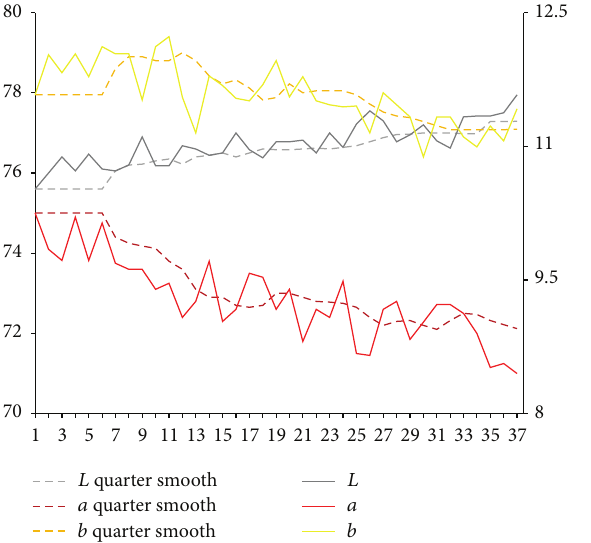
Figure 5: Lab value changing trend of facial overall.